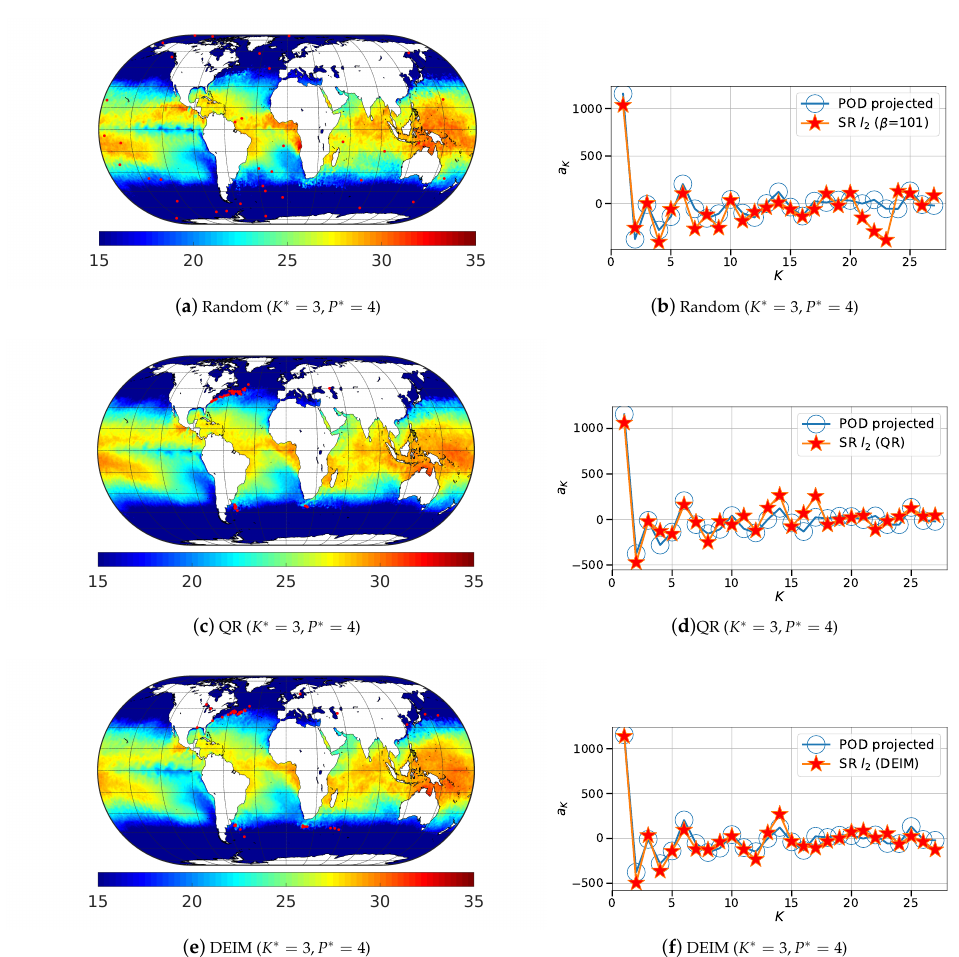
Figure 19. Comparison of the sparse reconstruction using Random, QR and DEIM sensor placement method on instantaneous snapshot for a marginally oversampled case ( K ∗ = 3, P ∗ = 4). The left subfigures show the reconstructed solutions for different sensor placement methods namely, random placement ( a ), QR with column pivoting ( c ) and DEIM ( e ) whereas the corresponding reconstructed coefficients using POD-based SR are shown in subfigures ( b , d , f ). Red dots on the contour plots represent sensor locations.